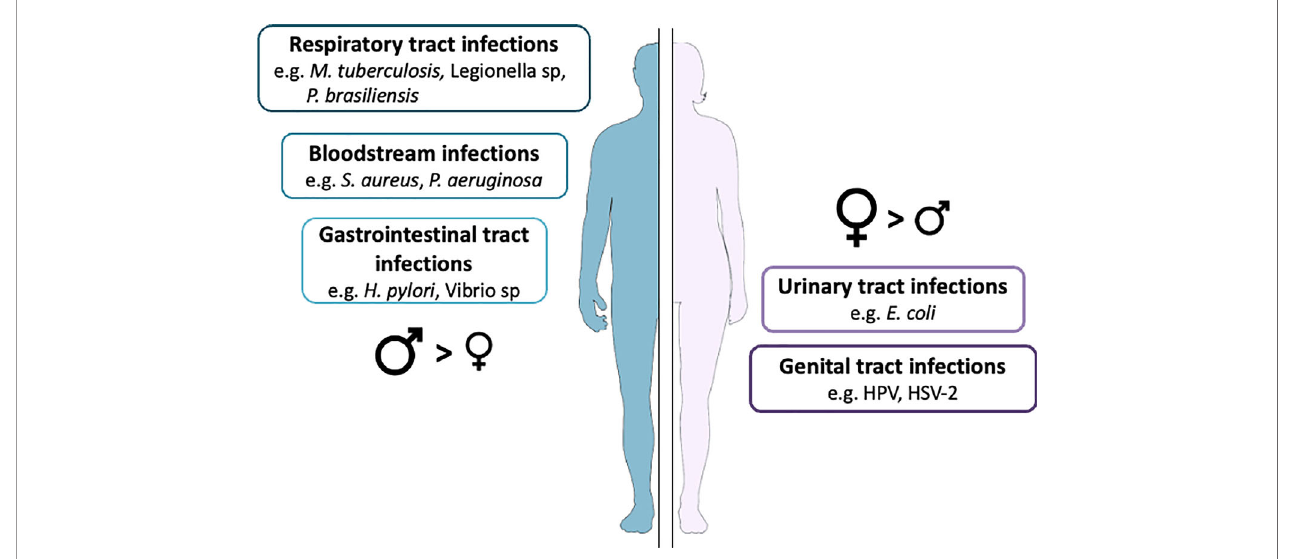
FIGURE 4 | Infection prevalence according to anatomical characteristics. Data extracted from a long-term cohort followed in our